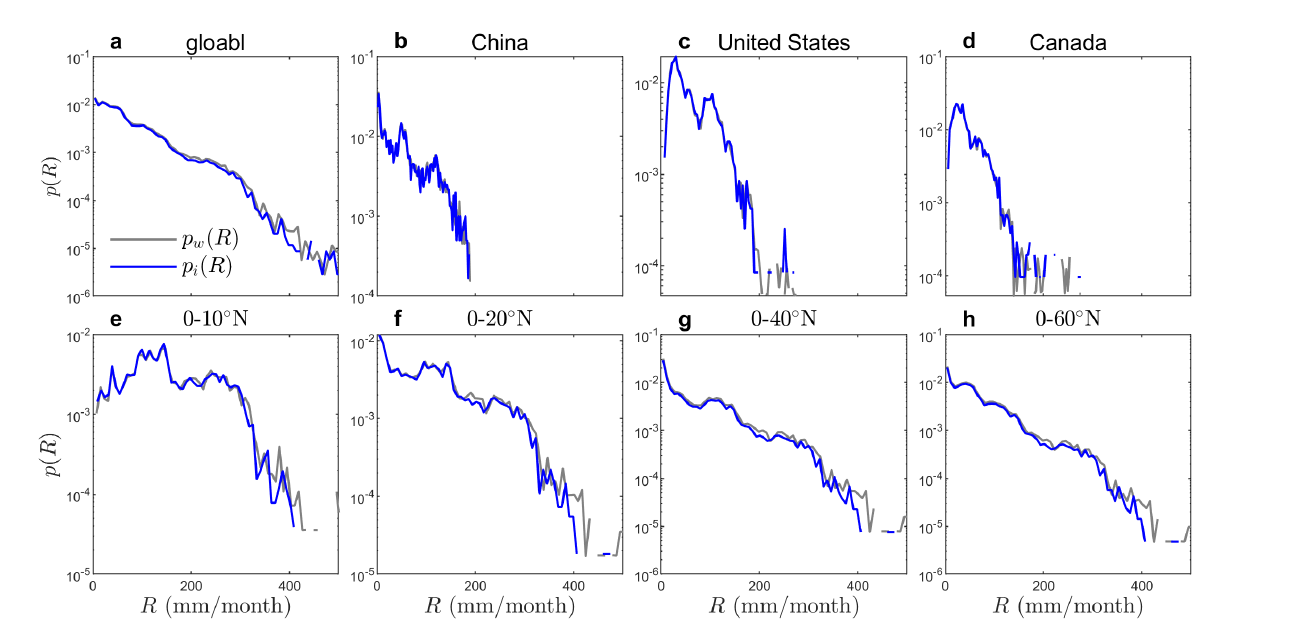
Figure 9. As in Figure 8 but for precipitation